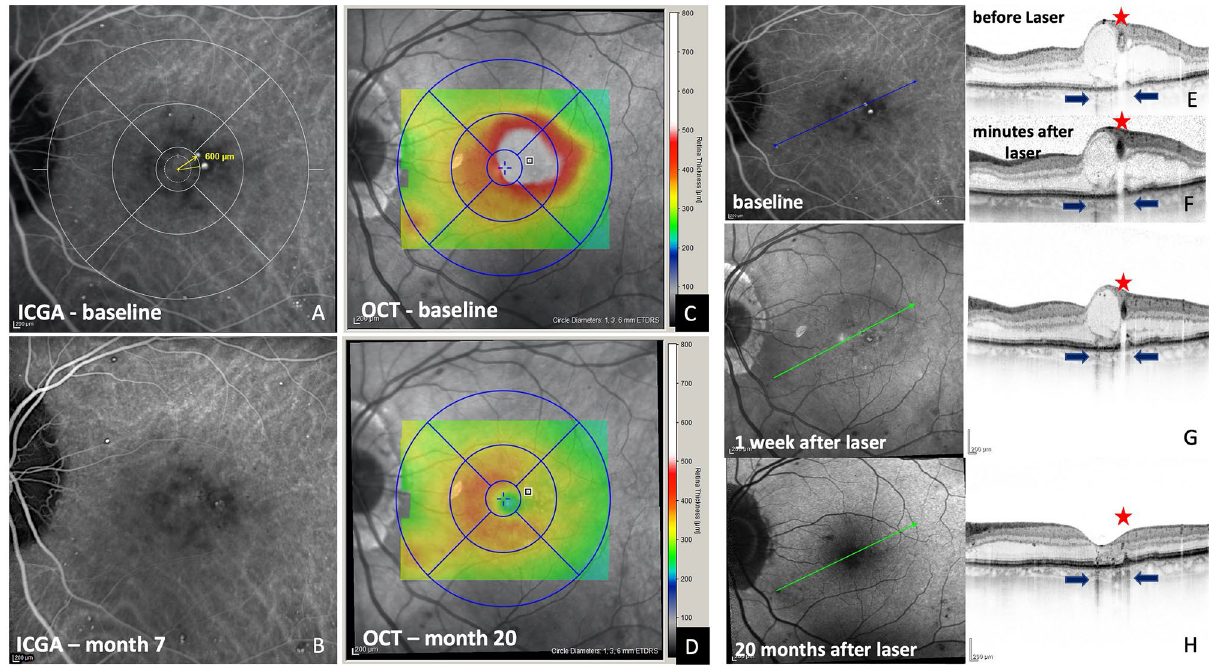
Figure 3. Multimodal imaging of a patient with treatment-naive center-involving diabetic macular edema. At baseline, indocyanine green angiography (ICGA) shows two teleangiectatic capillaries (TCs) at a distance of 600 µm from the foveal center, located right next to the peak of the edema ( A and C ). One representative OCT single scan that was created based on the patient’s ICGA images leads right through the center of the more superiorly located lesion ( E ; blue line). A darkening of the TCs lumen is seen in the OCT B-scan as immediate reaction to laser therapy (compare E and F ; red asterisks). The OCT scan acquired at baseline shows a small area of retinal pigment epithelium atrophy due to intermediate age-related macular degeneration before laser therapy right next and also underneath the TC ( E ; blue arrows). No additional retinal damage is seen in OCT one week after successful laser treatment ( F ). The TCs are no longer visible in ICGA, performed 7 months after laser therapy ( B ). Following closure of the TC, OCT reveals a small area of atrophy directly underneath this area. ( G ; right blue arrow). However, due to blockage of the OCT signal by the TC at baseline, it remains unclear if this area of atrophy was present before, or was induced by laser therapy. Best-corrected visual acuity (BCVA) increased from 20/32 Snellen VA at baseline to 20/25 9 months after laser therapy, while central subfield thickness (CST) decreased from 567 µm at baseline to 273 µm at month 9. BCVA and CRT remained stable at 20/25 Snellen and 282 µm, respectively 20 months after laser therapy without additional interventions ( D